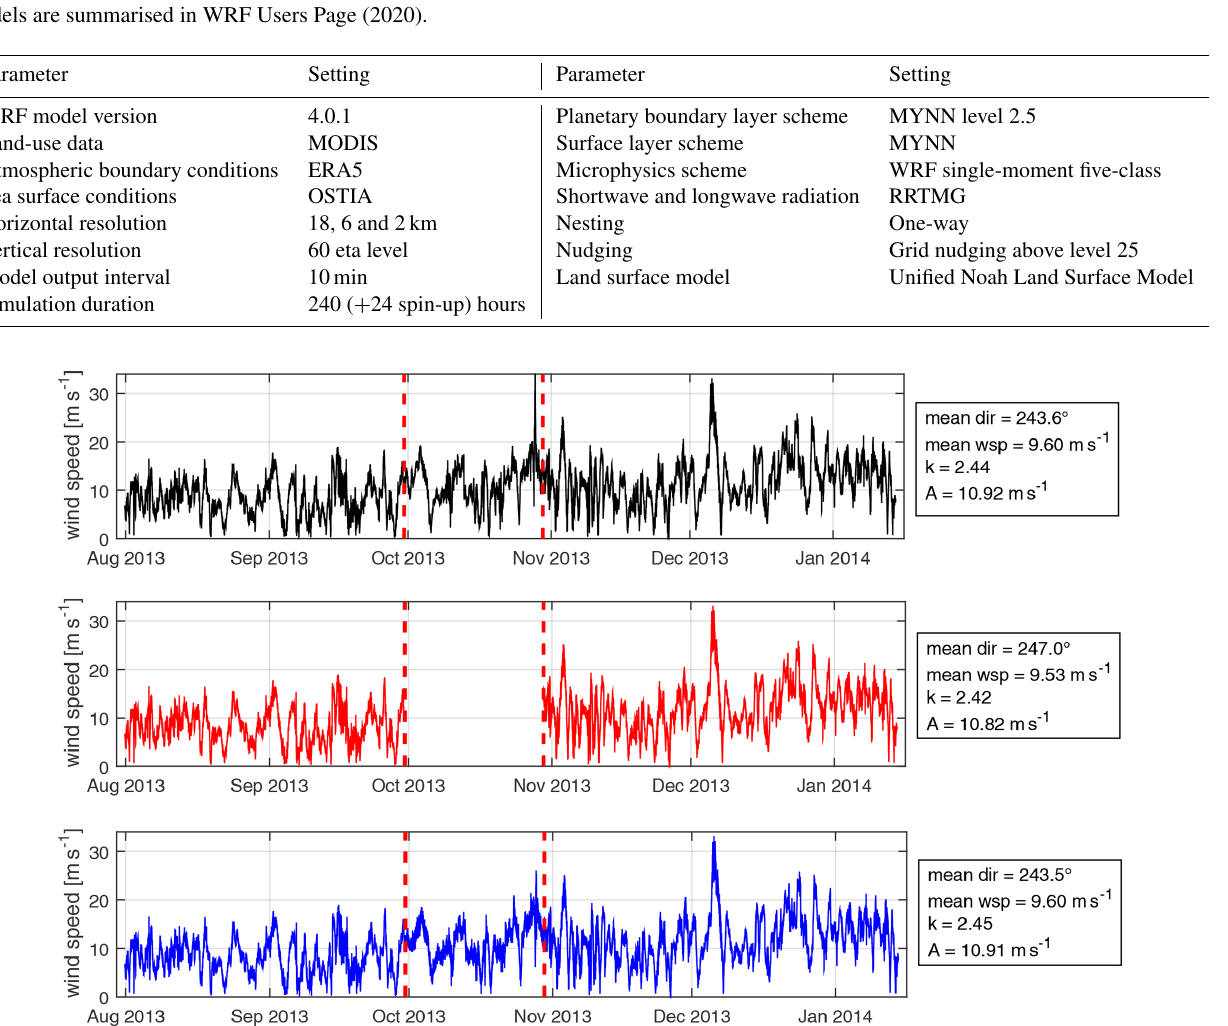
Figure 5. Generation and filling of artificial gaps – here demonstrated on the basis of the FINO3 wind speed time series and for a gap of 30d length starting on 30 September 2013. Original time series (only an excerpt is shown) are in black, incomplete time series with a generated gap are in red and time series with a filled gap (see procedure described in 3.2) are in blue. Derived statistical measures (mean wind direction, mean wind speed, and k and A parameters of fitted Weibull wind distribution) are shown for the three time series on the right